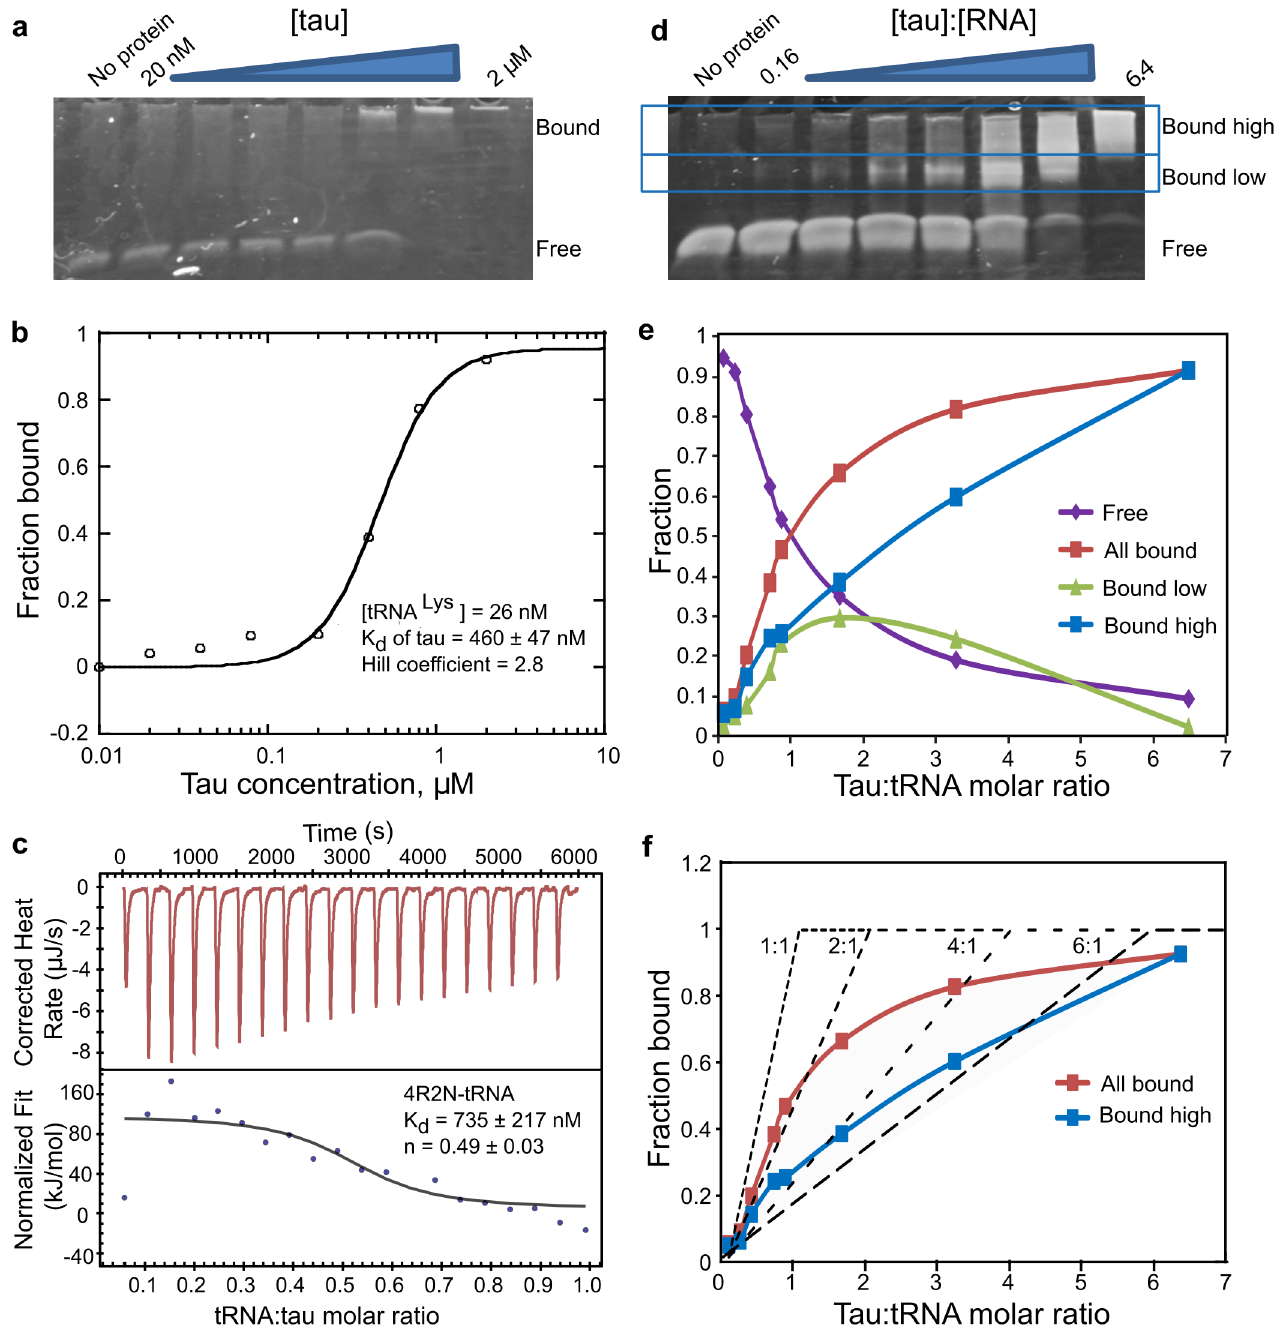
Fig 3. Tau tRNA binding by gel shift assay and isothermal titration calorimetry (ITC). (A) Direct titration experiment shows 4R2N tau induces a mobility shift in tRNA Lys . To determine the K d value, direct titration experiment was done, which requirestrace RNA concentrations to meet the assumption used in the equation that derivesthe K d value. The assumptionis that the total protein concentration is approximately the free protein concentration at equilibrium,and that protein bindingto RNA is negligible.In the direct titration experiments 26 nM, tRNA was used and protein concentration spans from 20 nM to 2 μ M. (B) The fraction of bound tRNA by 4R2Ntau plotted as a function of the monomeric tau concentration and fit to the Hill equation, y = 1 / [1 + (K d / x) n ]. (C) Yeast tRNA was titrated into solutionsof 4R2N tau in an ITC experiment. The top panel shows the raw incremental-titration. The area under each peak is integrated and plotted againstthe tRNA:tau molar ratio and fitted to an independent binding model (the bottom panel), as discussed in Materials and methods. (B-C) SEM is reportedfrom n = 3. (D) The stoichiometric bindingexperiments were performed by varying the tau:RNA molar ratio at a constant 2.6 μ M concentration of tRNA, which approximates the saturation concentration (more than 5 times the K d of 460 nM). The representative data of 3 independent experiments are shown. (E) Fraction of bound tRNA from the